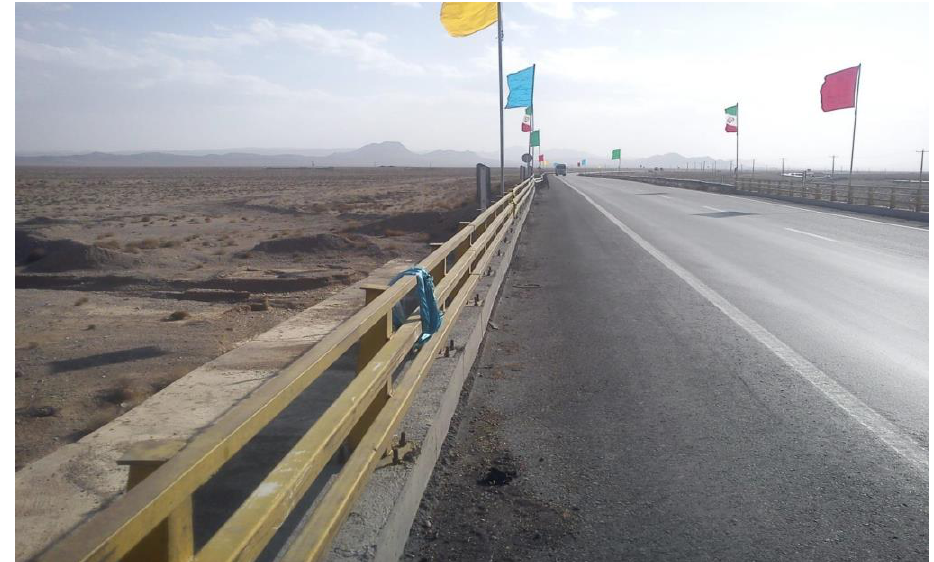
Figure 14. An example of structural damage in bridge No. 3.